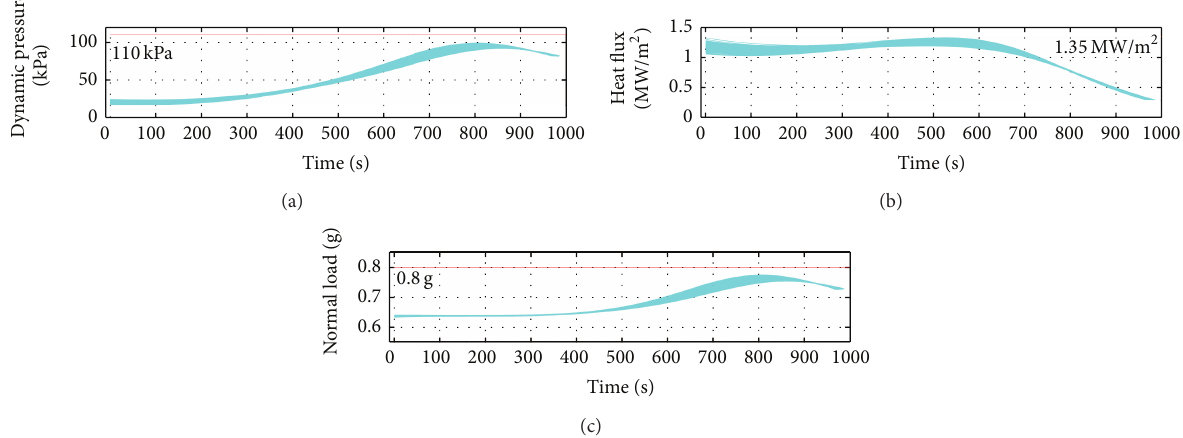
Figure 14: Path constraint plot for the runs. (a) Dynamic pressure remains within 110kPa, (b) heating rate stays within 1.5 MW/m 2 , and (c) the normal load is within 1g.